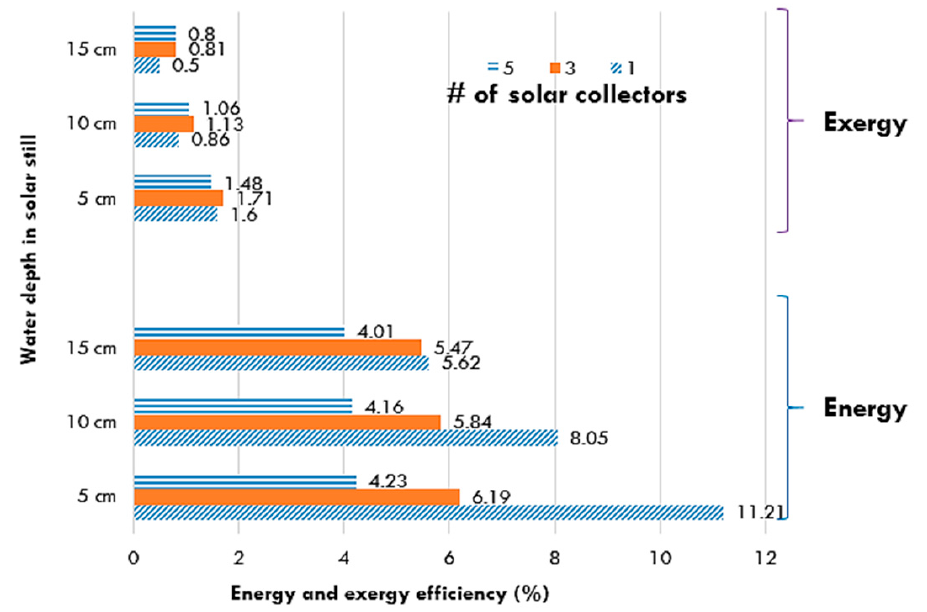
Figure 11. Energy and exergy of an active solar still with different saline water depths and optimum number of solar collectors. Table 7. Exergy efficiency in solar stills.